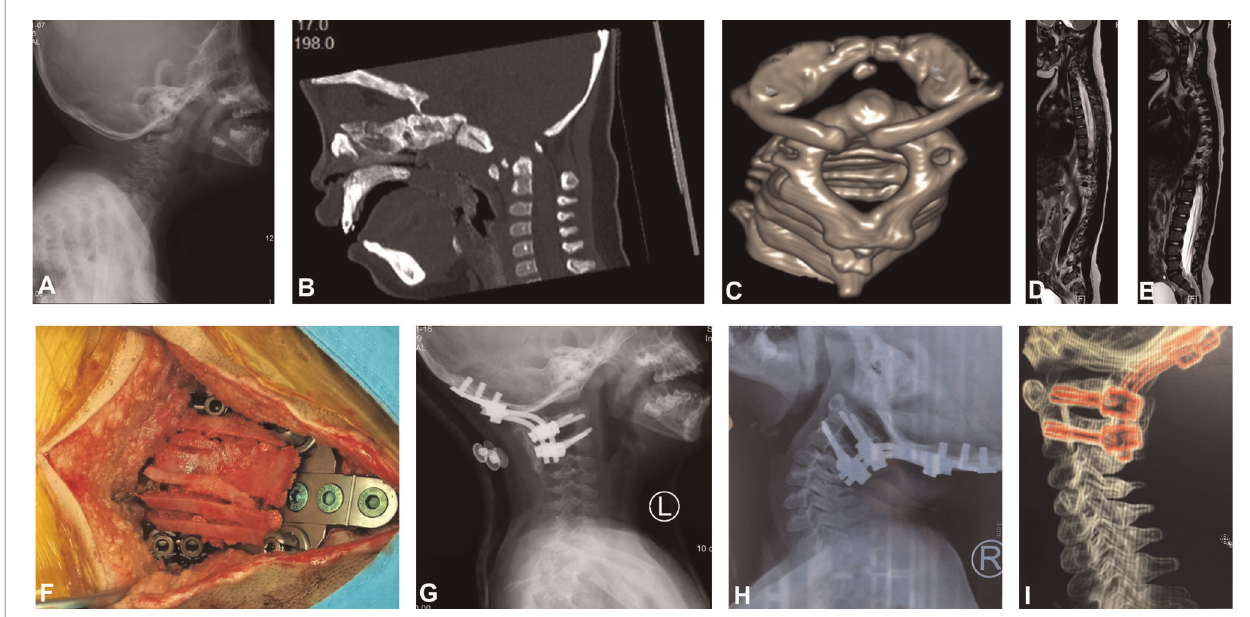
FIGURE 1 | Case 2. A 3-year-old female child with DS, atlantoaxial dislocation, OsO, and spinal cord injury. ( A ) Dynamic X-ray showed that the ADI increased signi fi cantly, and a shift of the atlas anterior and lower to the axis. ( B ) Cervical sagittal reconstruction computed tomography (CT) and ( C ) three-dimensional reconstruction showed atlantoaxial dislocation with OsO. ( D and E ) Magnetic resonance imaging (MRI) showed that the upper cervical spinal cord was compressed by the upper posterior part of the odontoid process, and the spinal cord was edematous and degenerated. ( F ) Reduction was performed under cranial traction during surgery. ( G ) Postoperative X-ray fi lms showed atlantoaxial screw rod fi xation. ( H and I ) At postoperative 1 year, atlantoaxial CT and X-ray showed good atlantoaxial fusion and satisfactory internal fi xation